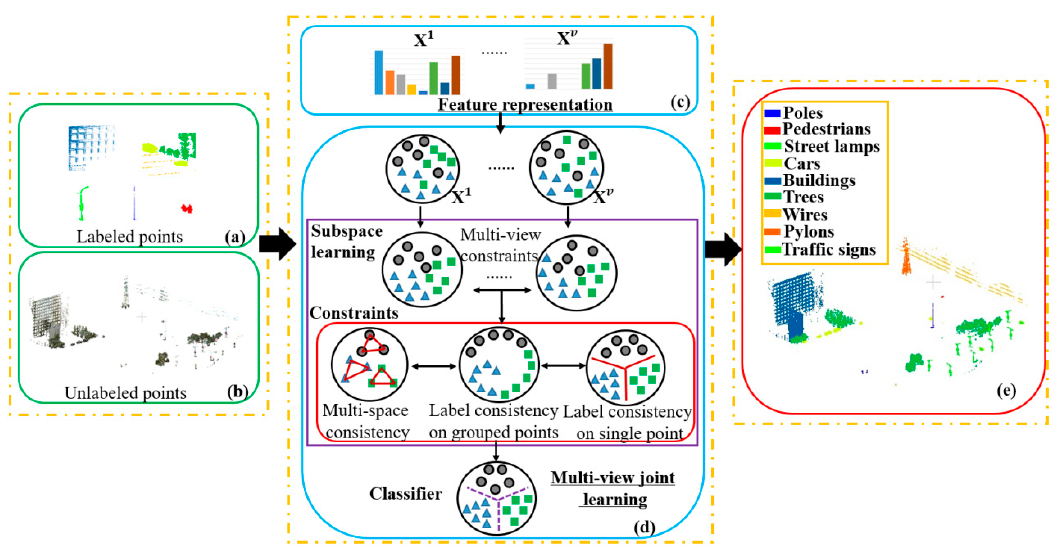
Figure 1. The flowchart of the proposed method. ( a ) Training data; ( b ) testing data, ( c ) feature extraction; ( d ) the process of multiple views and space representation consistency under constraints of label consistency (MvsRCLC); ( e ) classification results. X 1 and X v represent the first view and the v th view features of the point cloud, respectively.